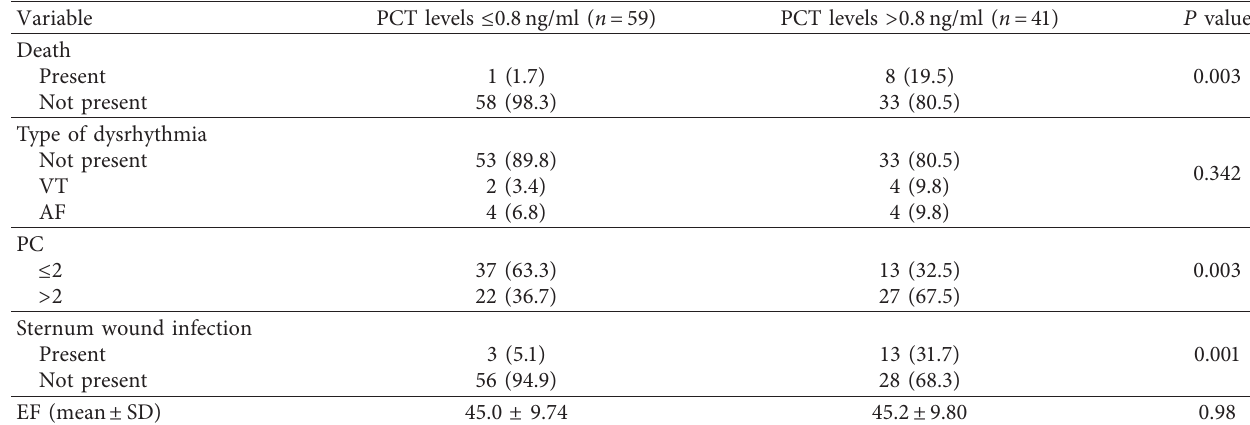
Table 2: Postoperative data and adverse events.